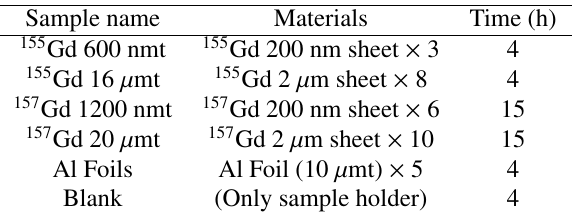
Table 3. E ff ective thickness and measurement time of samples for capture cross section measurement.